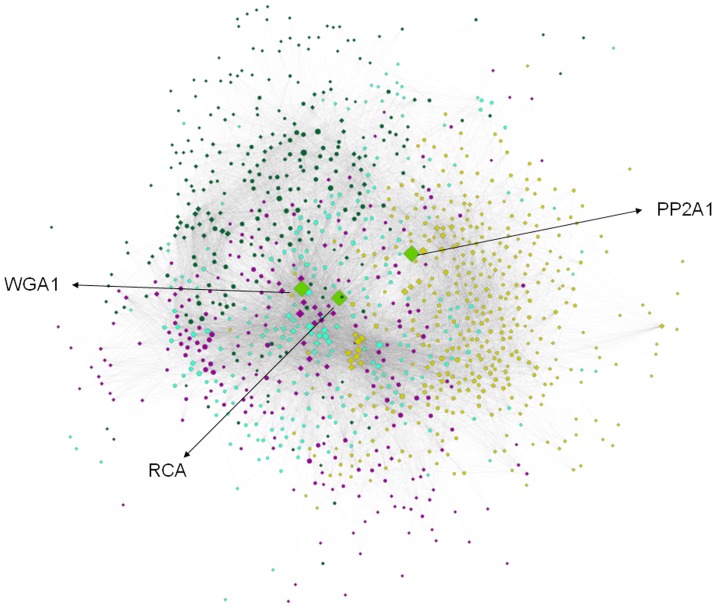
The lectin-glycan network generated using the RFU cut-off of 5000 is shown.Circles represent glycan nodes and diamonds represent lectin nodes. The nodes are color coded according to their communities. Three hub nodes (shown in green diamonds) are PP2A1, WGA1 and RCA.